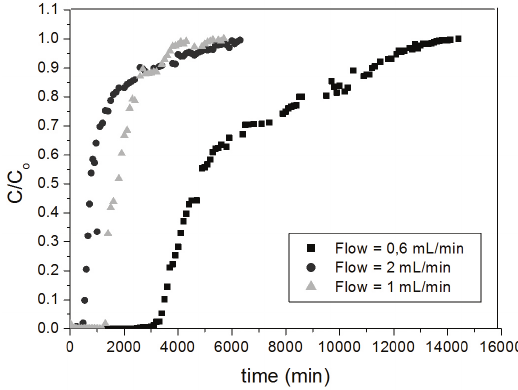
Figure 1. Breakthrough curves for the system of Pb 2+ /calcined Fluidgel for different flow, particle size = 0.855 mm and C = 0.24 mmol/L. 0 Table 1. MTZ, q , q and %R for lead removal on Fluidgel TACal. u t L System